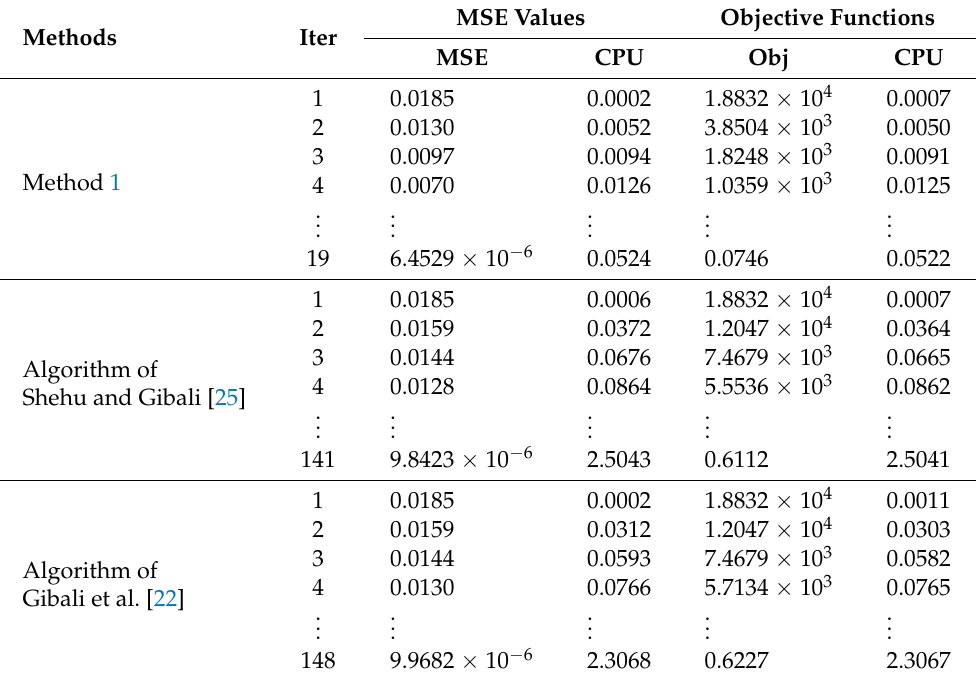
Table 2. Results of MSE values, objective function values, and CPU time in seconds for each method and each iteration ( P = 2048, K = 1024, m = 30, MSE < 10 − 5